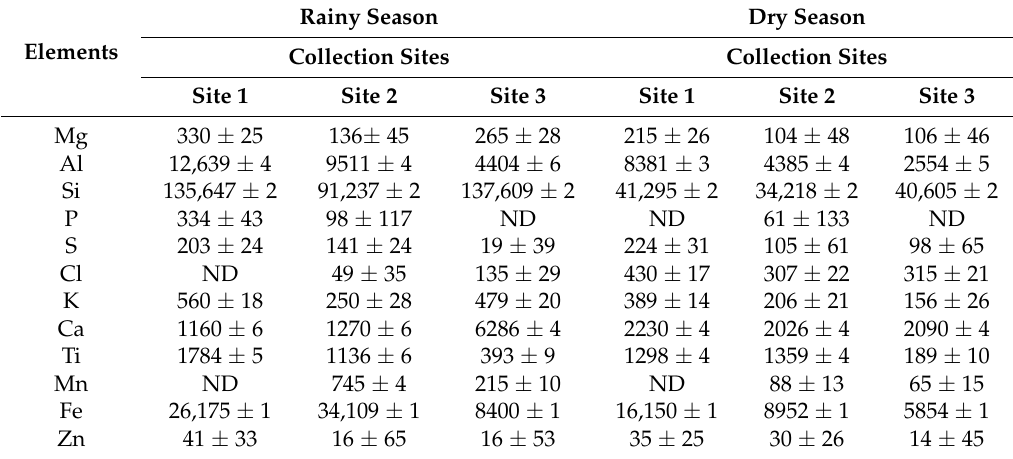
Table 2. Inorganic elements detected in the waters collected in sites 1, 2, 3 in Tocantins River, Brazil.